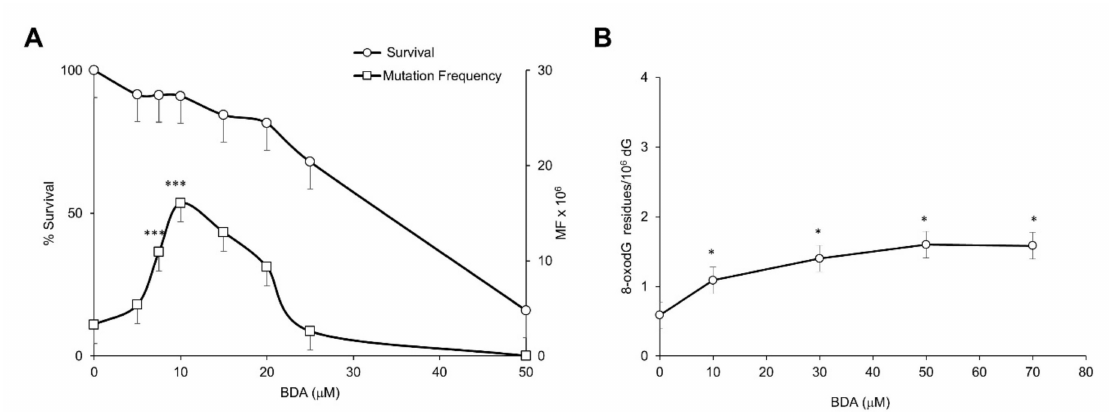
Figure 3. Cytotoxicity, Hprt mutation frequency and DNA base oxidation induced by BDA in V79-4H cell line. ( A ) Cyto- toxicity and Hprt mutation frequency after 3 h exposure to BDA at the indicated doses; ( B ) DNA 8-oxodG levels after 3 h exposure to BDA at the indicated doses as measured by HPLC/EC. Furan surviving cells are expressed as percentage of the surviving untreated cells. Mutation frequencies (MF) are calculated as described in M&M. DNA 8-oxodG levels are expressed × 10 6 dG. Bars indicate SD. * p < 0.05; *** p < 0.0001 by Student t